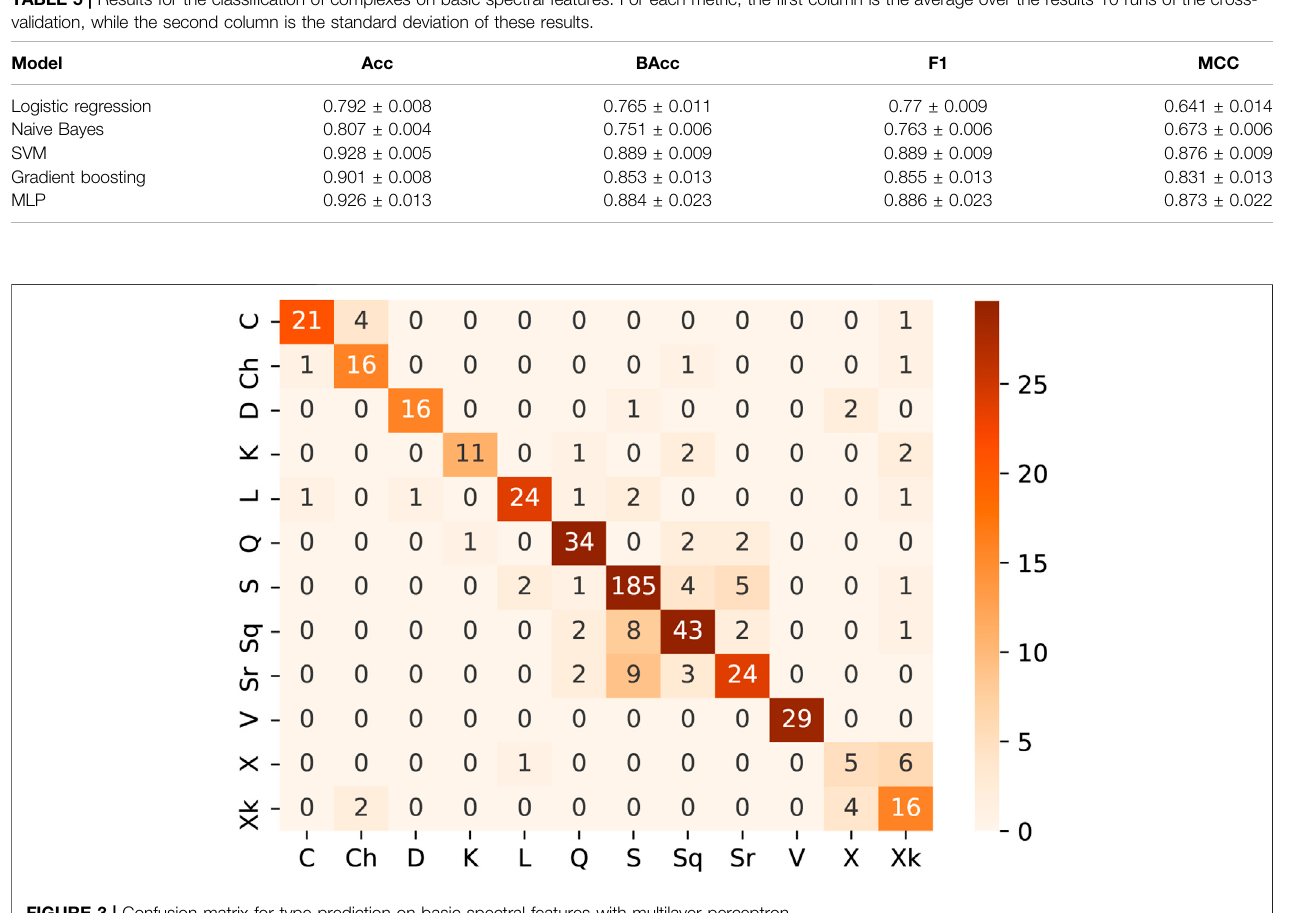
FIGURE 3 | Confusion matrix for type prediction on basic spectral features with multilayer